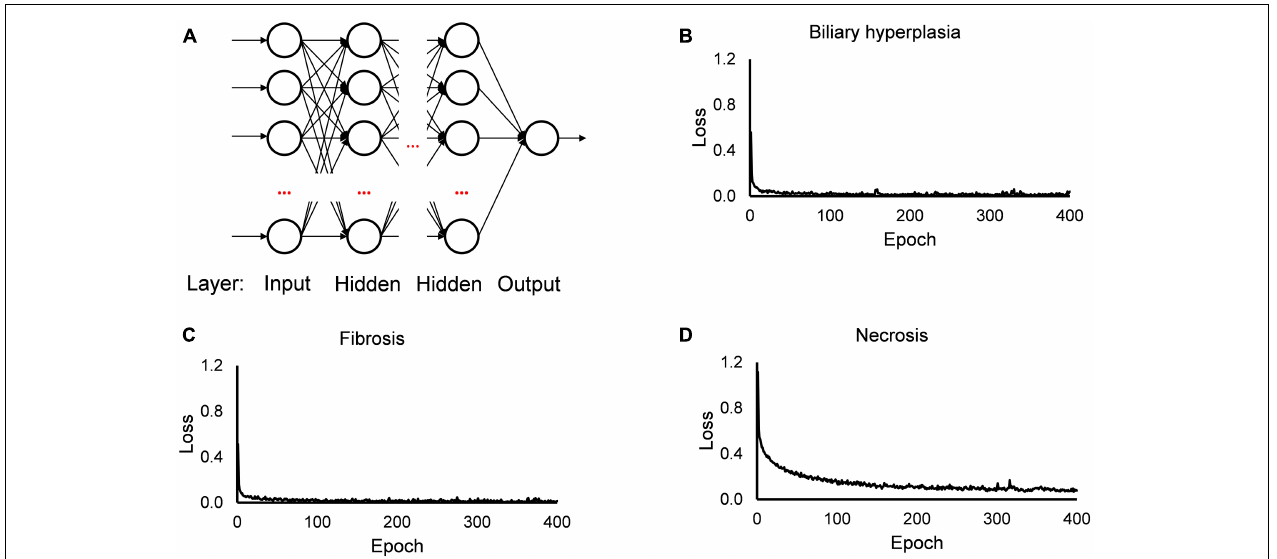
FIGURE 1 | Diagram of single-task DNN and loss function during training. (A) Diagram of single-task DNN model. (B–D) Change of loss function during training single-task DNN model for Biliary hyperplasia, Fibrosis, and Necrosis, respectively.